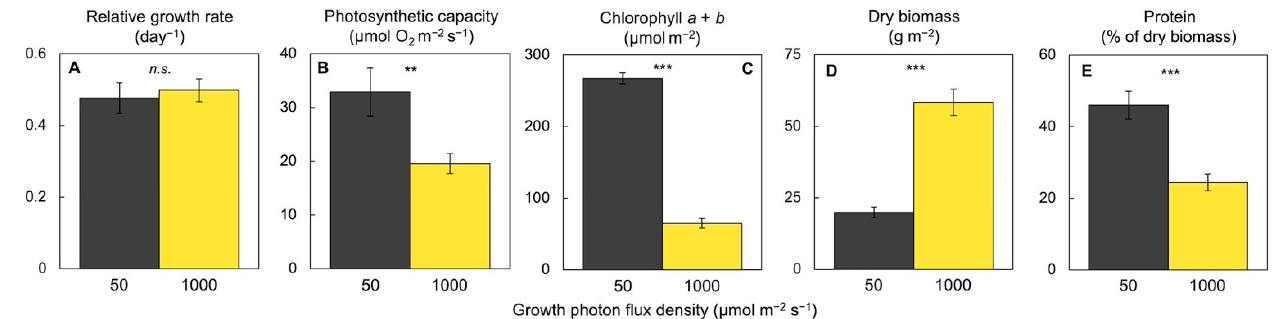
Figure 7. Effect of growth light intensity on ( A ) relative growth rate, ( B ) photosynthetic capacity, ( C ) chlorophyll content, and ( D ) biomass per frond area as well as ( E ) percentage of protein of this biomass for Lemna gibba . Data from [23]. n.s ., not significant. Asterisks indicate significant differences at p < 0.01 (**) or p < 0.001 (***).